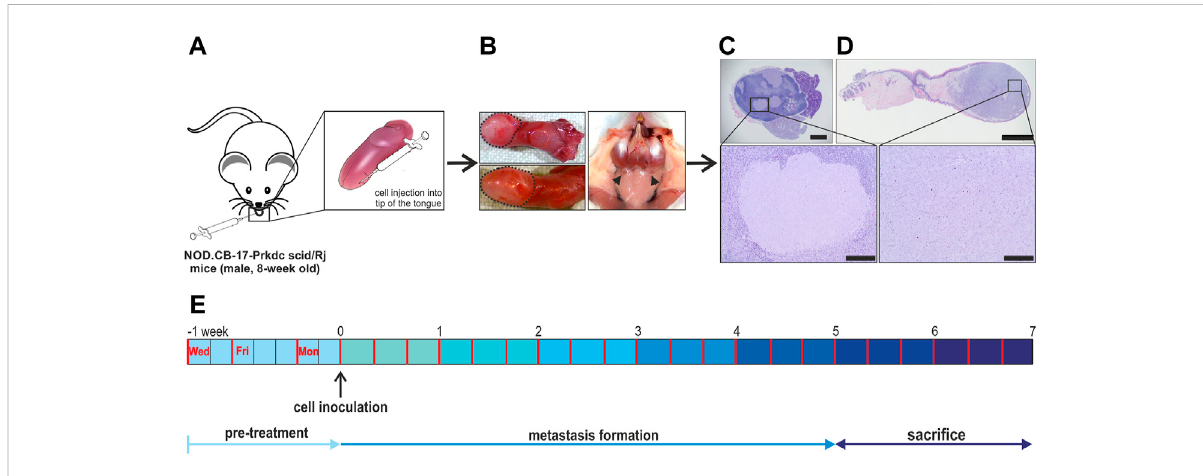
FIGURE 2 Lymphogenic metastasis model overview. (A) 1.0 × 10 5 FaDu wildtype cells were injected into the right side of the tip of the tongue of 8-week- old, male,immunode fi cient mice. (B) Thesacri fi cewas doneafter 5 – 7 weeksofmetastasis formation.Here, thetongue as wellas thecervicallymph nodeswerecollectedforfurtherhistologicalprocessing.Thetonguetumorisencircledbyblackdashedlinesandcervicallymphnodesareindicated byblackarrowheads. (C,D) Foridenti fi cationandquanti fi cationoftheprimary tumor andmetastasisthedissected tonguesand relatedcervical lymph nodes were HE stained and further analyzed. (E) Schematic overview of the full experimental plan containing drug delivery 3-times per week and the sacri fi ce of animals after 5 – 7 weeks. In the beginning animals were classed into four treatment groups: TFP & TG, TFP, TG and vehicle. Scale bar: 1 mm (C) , 2 mm (D) , zoom out 200